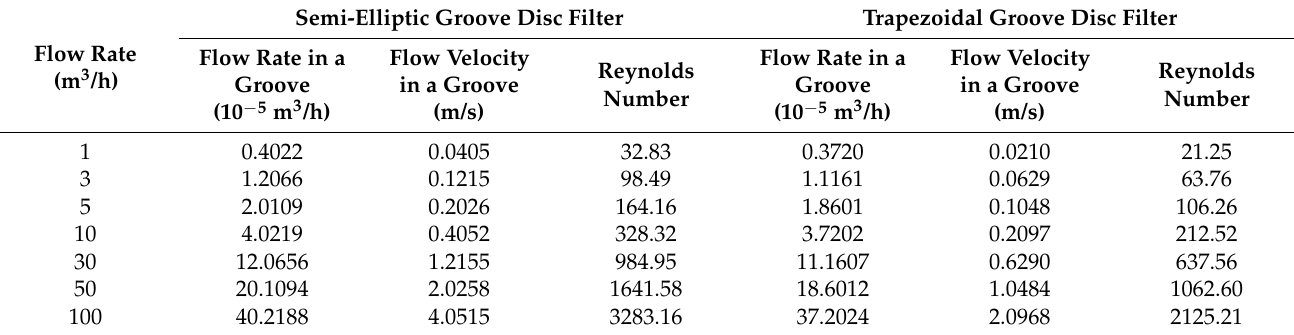
Table 3. Calculation of Reynolds number.